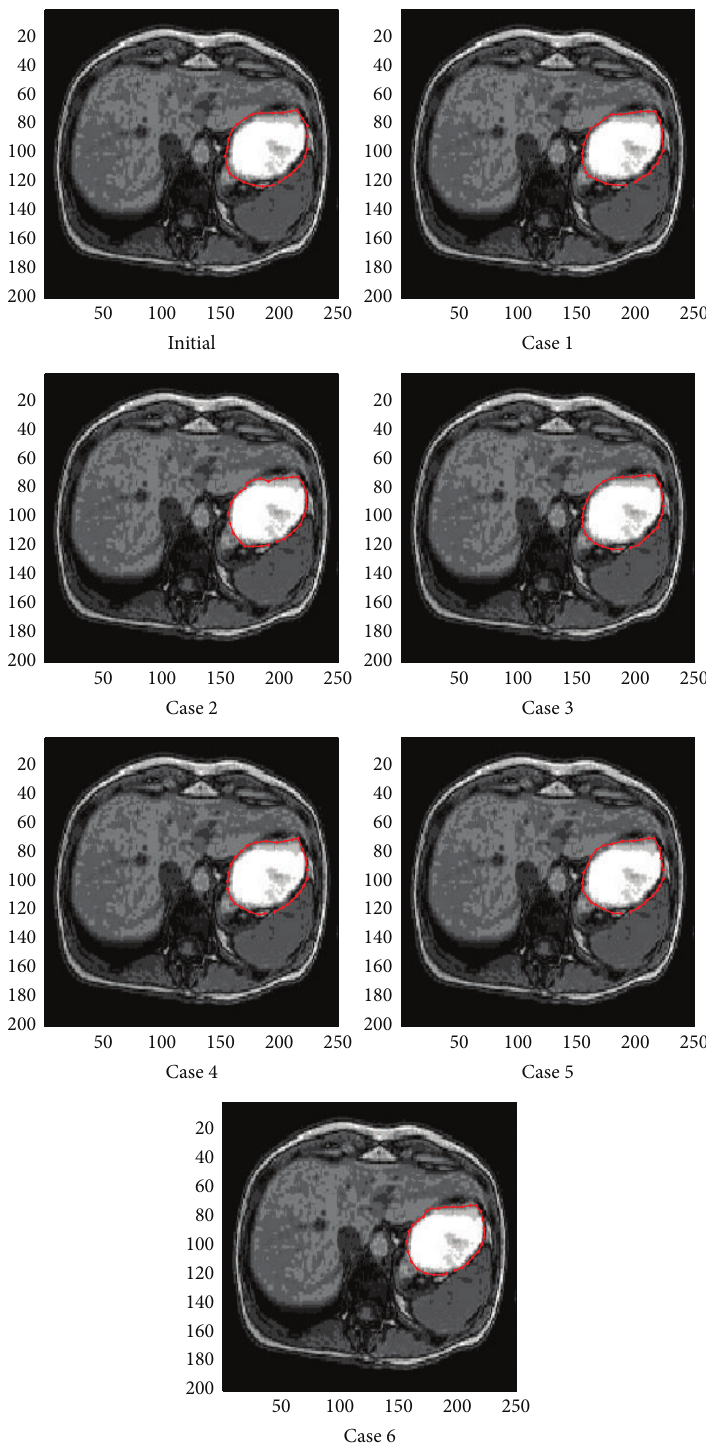
Figure 19: Active contour model implementation by “proposed multiswarm PSO” method for different cases of inertia. Results for “MRI” image with control points = 30, 𝛼 = 0.17 , 𝛽 = 0.15 , and Γ = 0.20